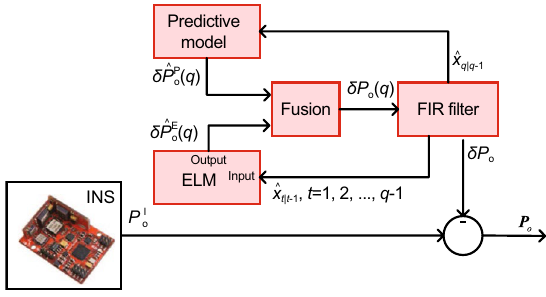
Fig. 3 The predictive model/ELM integrated scheme when the UWB data is